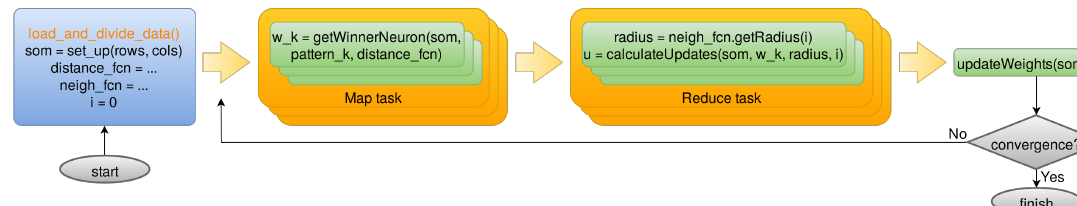
Figure 6. Map-Reduce design for Self-Organized Maps: the map task determines the winner neuron for each input source, whereas the reduce task calculates partial weight updates for each winner neuron; the driver commits the weight updates and takes care of the learning